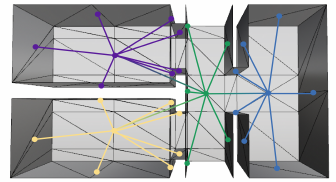
Figure 9. Conceptual representation of G (cid:48)